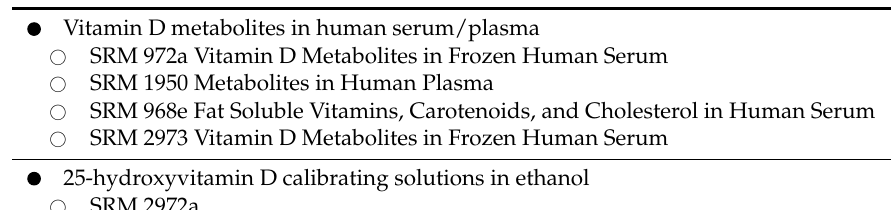
Figure 3. Standardization process for assays of serum 25-hydroxyvitamin D. Table 8. Standard Reference Materials from the National Institute for Standards and Technology.